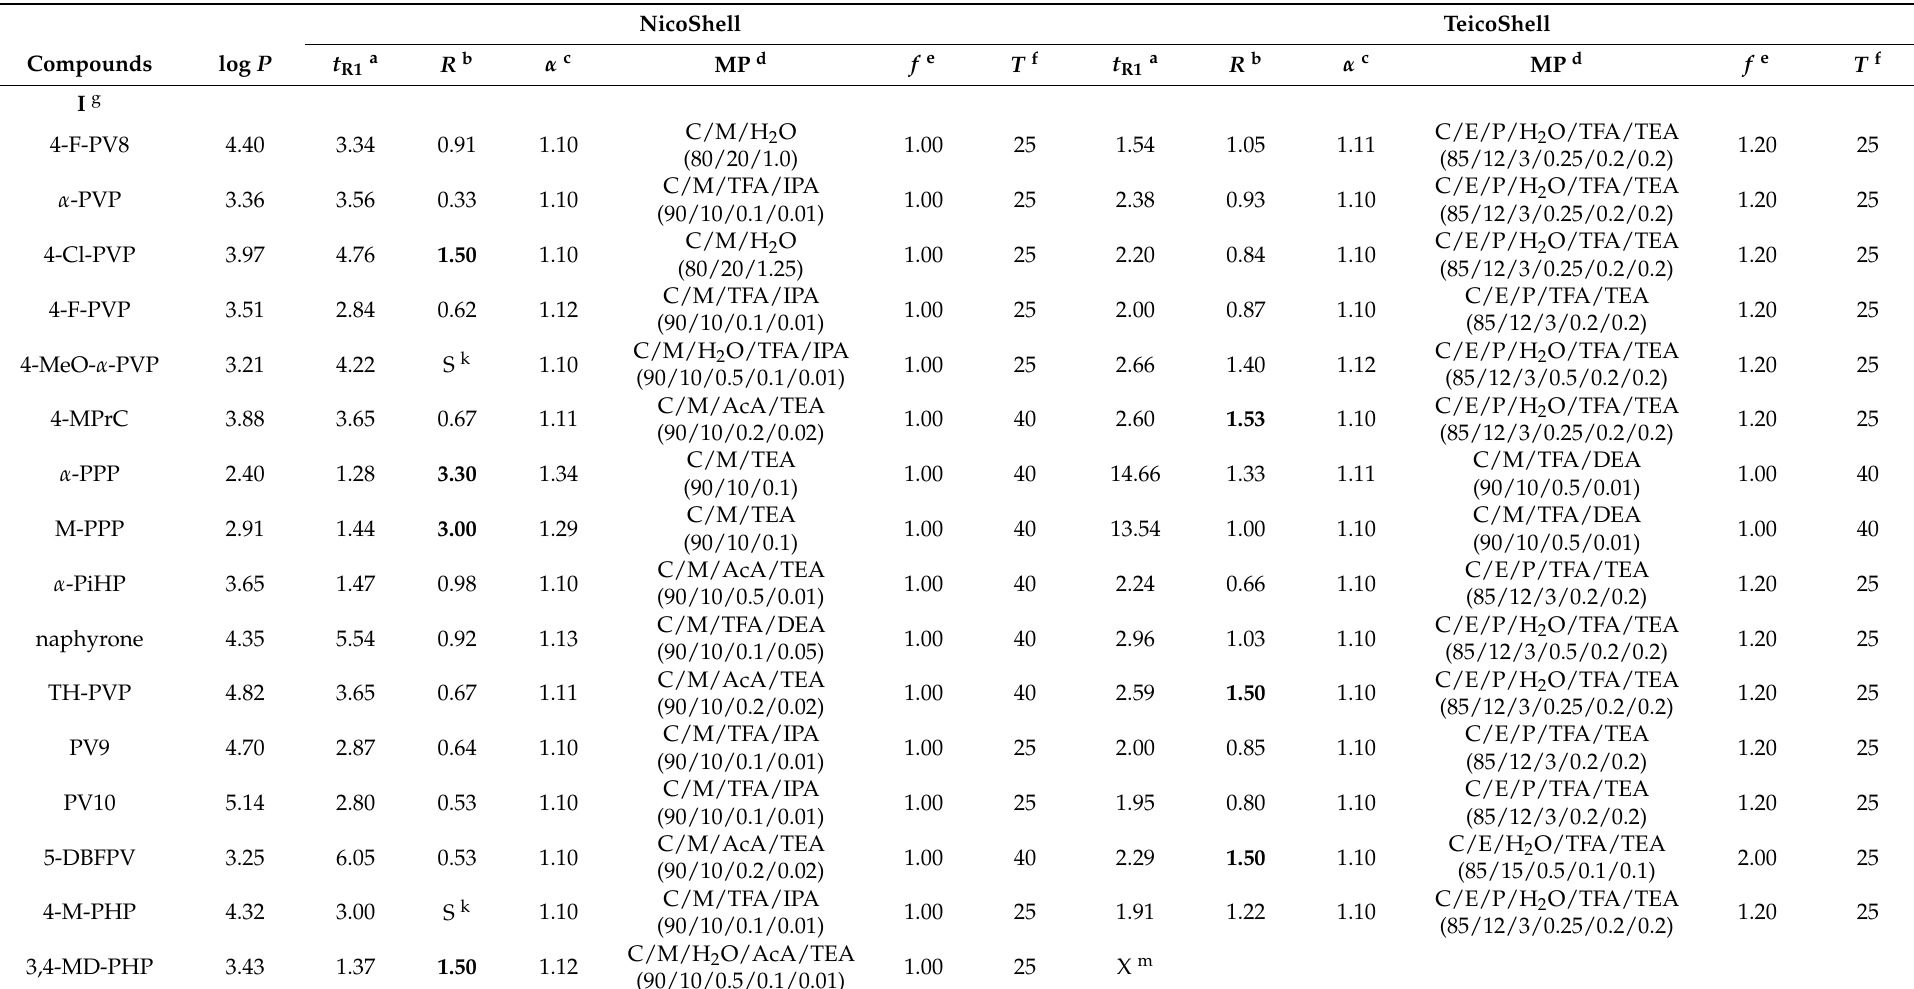
Table 1. The best results obtained on the NicoShell and TeicoShell columns. SFC conditions: back pressure (BP) 13.8 MPa; UV detection 254 or 280 nm; injection volume 0.2–1.0 µ L. NicoShell